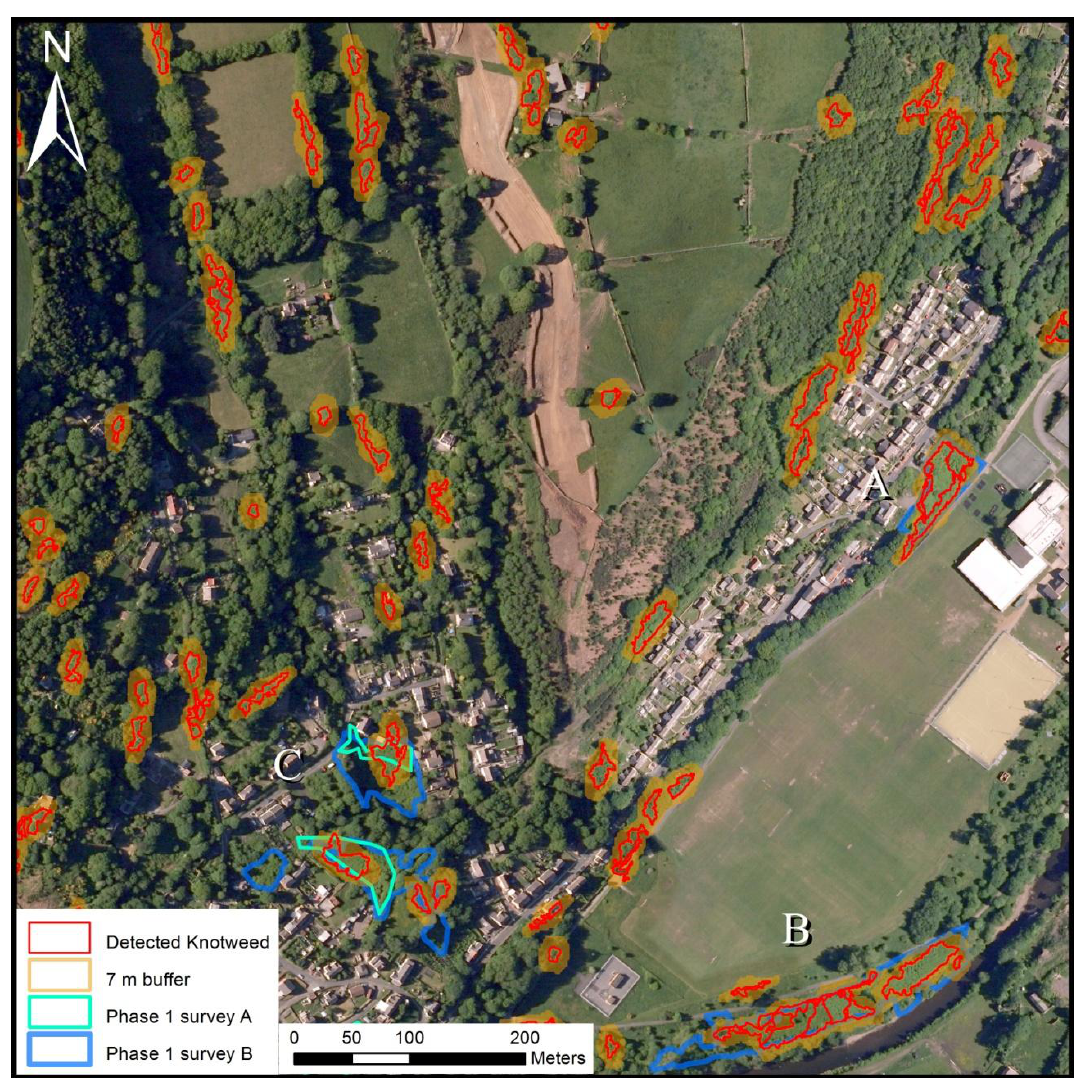
Figure 14. Algorithm automated detection trial, Pontardawe (South Wales,